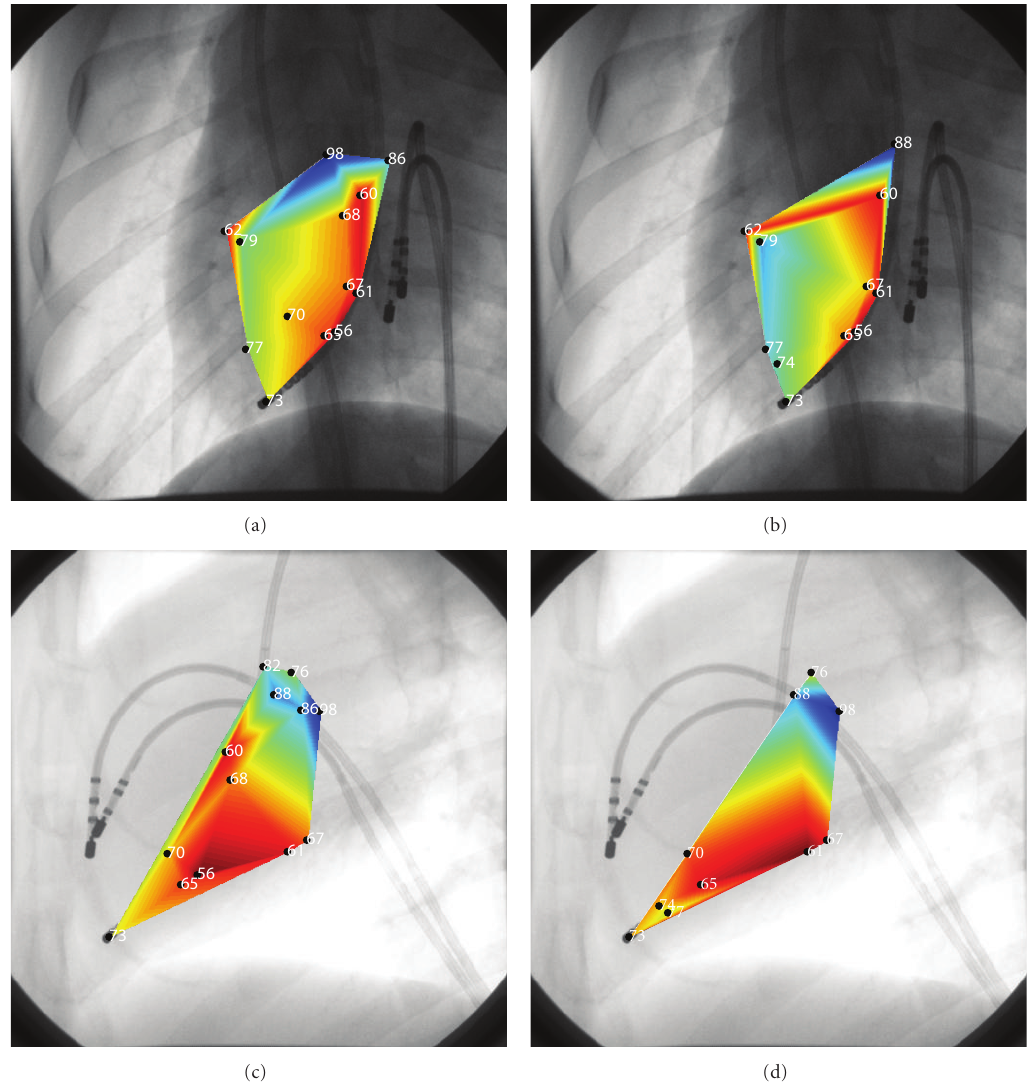
Figure 15: 2D/3D Registration sample images. (a, (c) Ground truth isochronal maps superimposed directly on the first dataset in the posterior view and left lateral view respectively. (b), (d) Single-view isochronal maps stemming from the convex hull demonstrate that isochronal times disappear in both the posterior view and left lateral views due to depth estimates of about 10 mm. However, fastest times are still near pacing catheter using the monoplane depth estimation